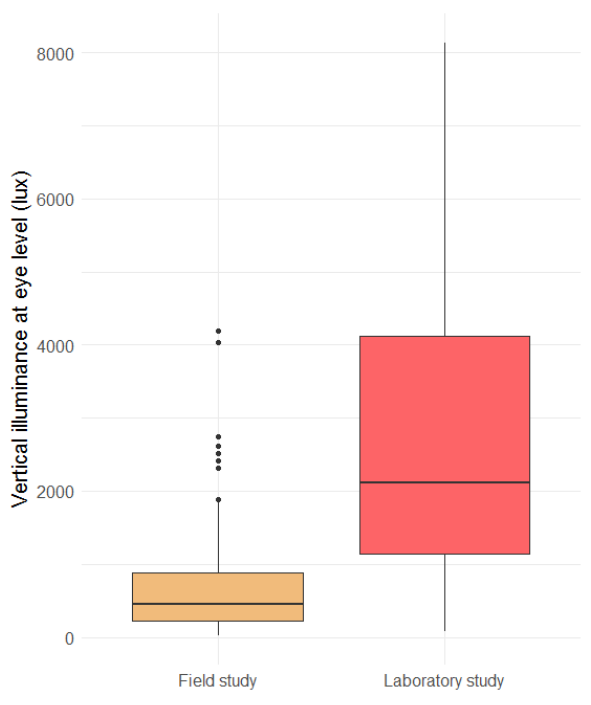
Figure 1. Boxplots of vertical illuminance at eye level between the field study and the laboratory study.